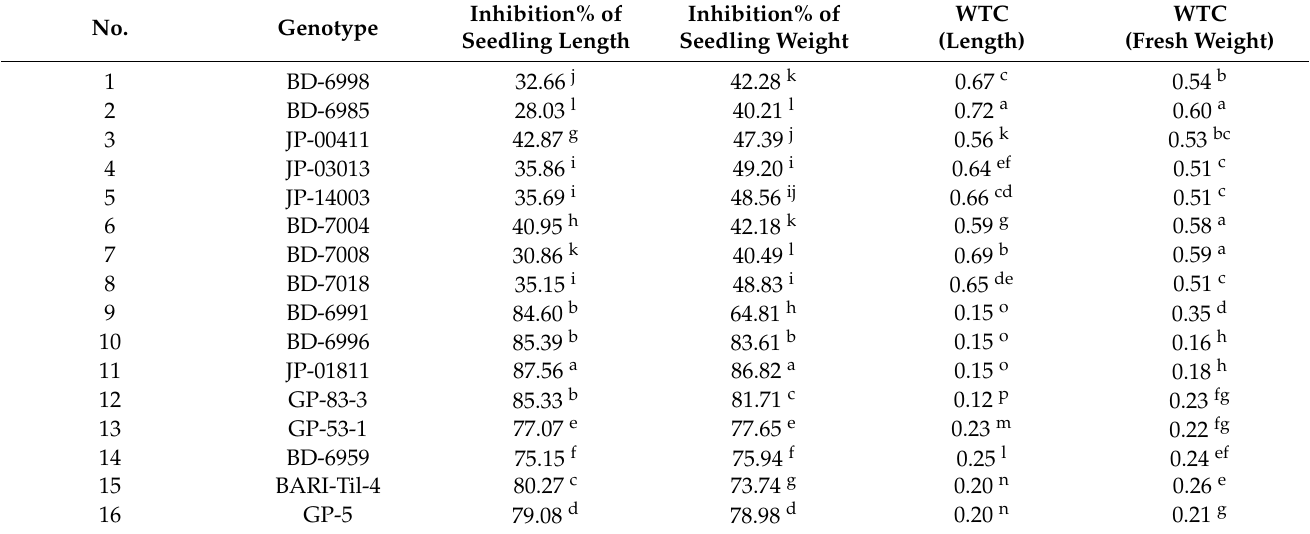
Table 5. Growth inhibition rates and waterlogging tolerance coefficients (WTCs) at the seedling stage of sixteen sesame genotypes under waterlogged conditions for 48